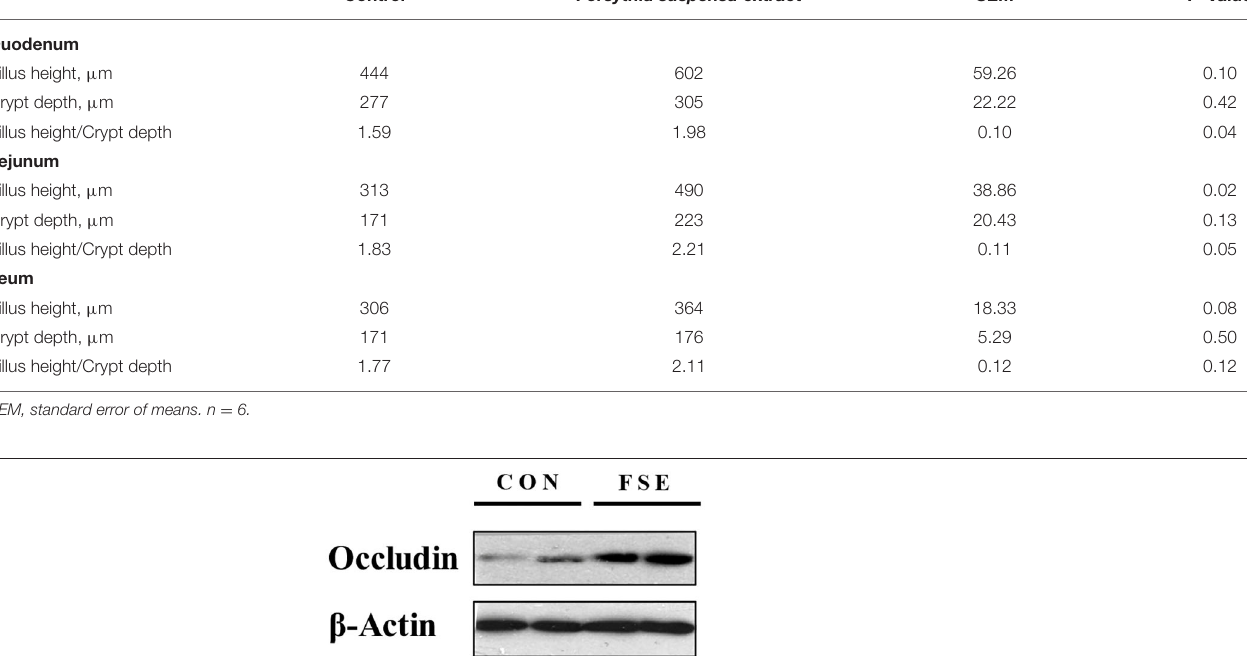
TABLE 3 | Effects of Forsythia suspensa extract on intestinal morphology of suckling piglets. Control Forsythia suspensa extract SEM P -Value